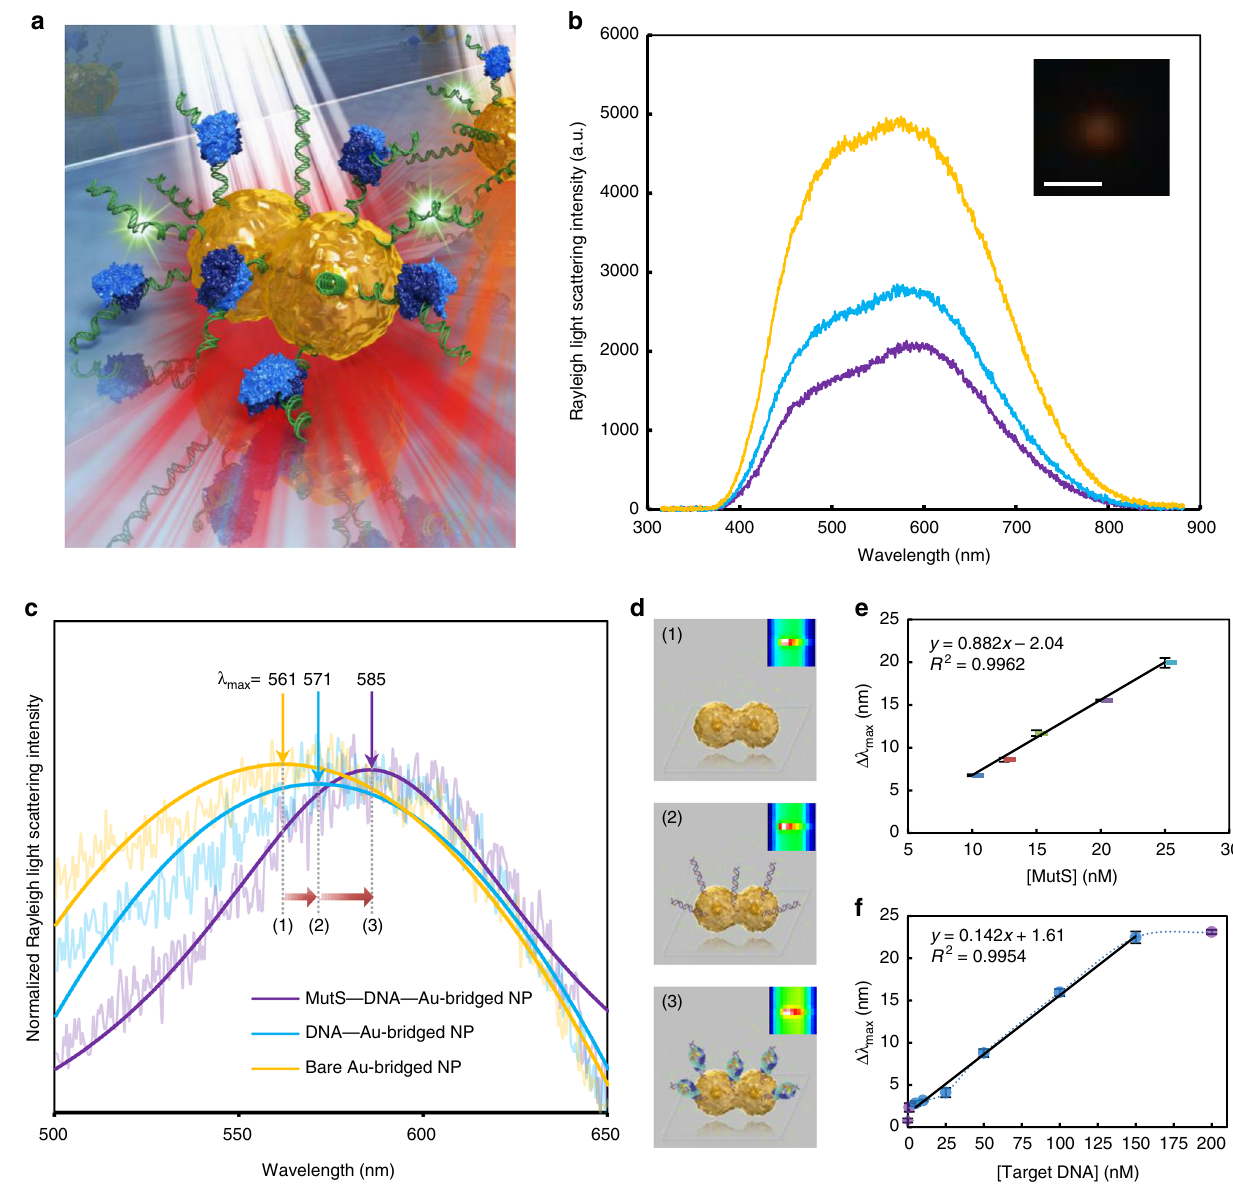
Fig. 2 Fabrication of single nanoparticle (NP) biosensor of high sensitivity and fi delity. a Schematic illustration of single NP sensing (sNPS) for identifying single point DNA mutations. b Representative Rayleigh light scattering (RLS) spectra and in-situ dark- fi eld microscopy image of an Au-bridged NP. Scale bar, 1 μ m. c Localized surface plasmon resonance (LSPR) λ max shifts upon binding of DNA and MutS. Same line legend for ( b , c ). Each step of molecular binding (1, 2, and 3) illustrated in ( d ). Insets: real-time images of a single NP obtained with charge-coupled device (CCD) camera. e Concentration of MutS for adequate signal response. Calibration curve showing the linear relationship between the Δλ max and various concentrations of MutS. f Limit of detection (LOD) of the mutant DNA target. Calibration curve showing the linear relationship between the Δλ max and various concentrations of target DNA. For all panels, error bars represent mean ± S.E.M. All experiments were performed in triplicate. Source data of Fig. 2b, c, e, and f are provided as a Source Data fi